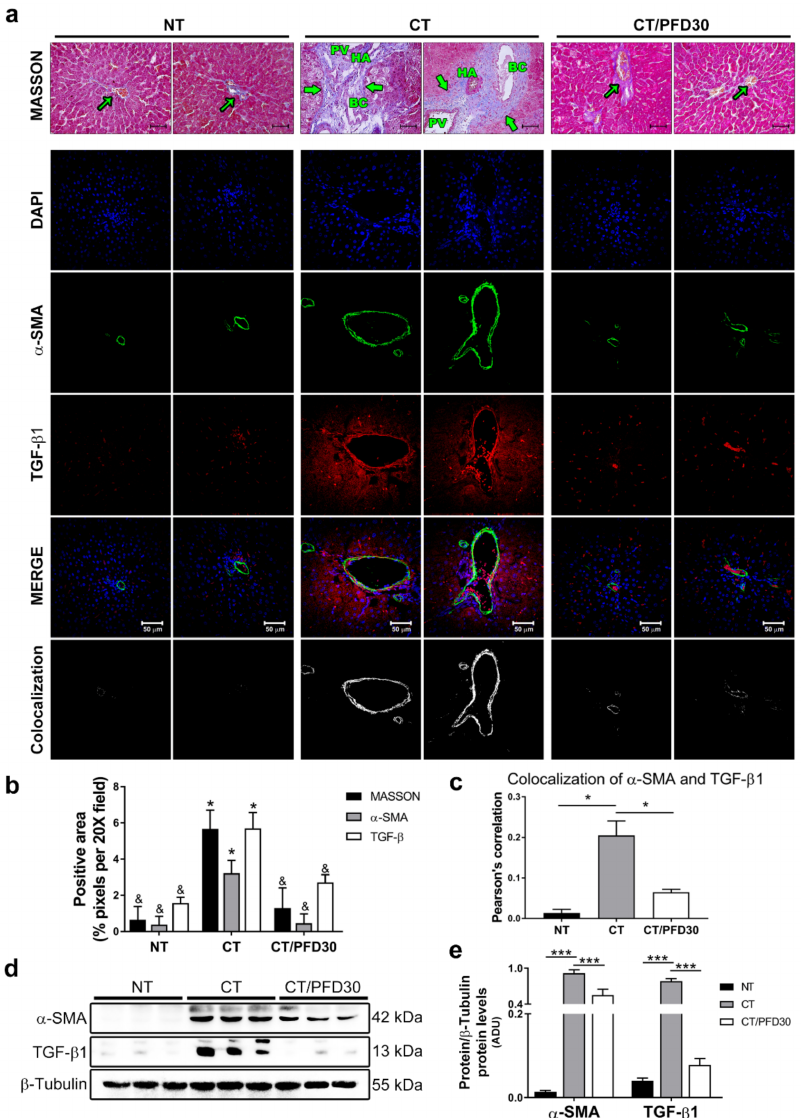
Figure 3. Liver fibrosis reduction by pirfenidone in MRHM. ( a ) Masson ´ s staining and IF for α